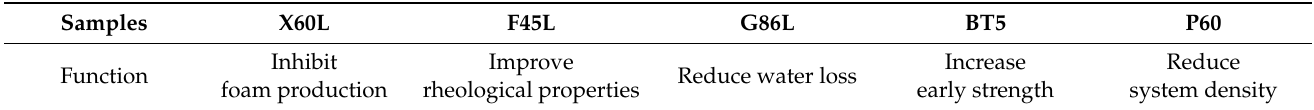
Table 3. Functions of cement slurry additives.